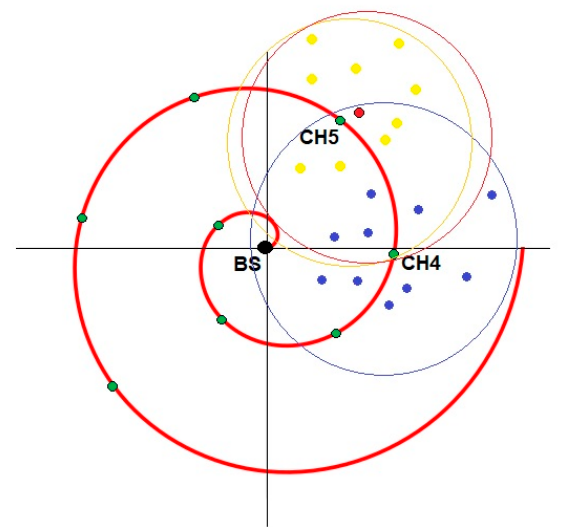
Figure 6. Multi-cluster head positioning algorithm (CHP) example.